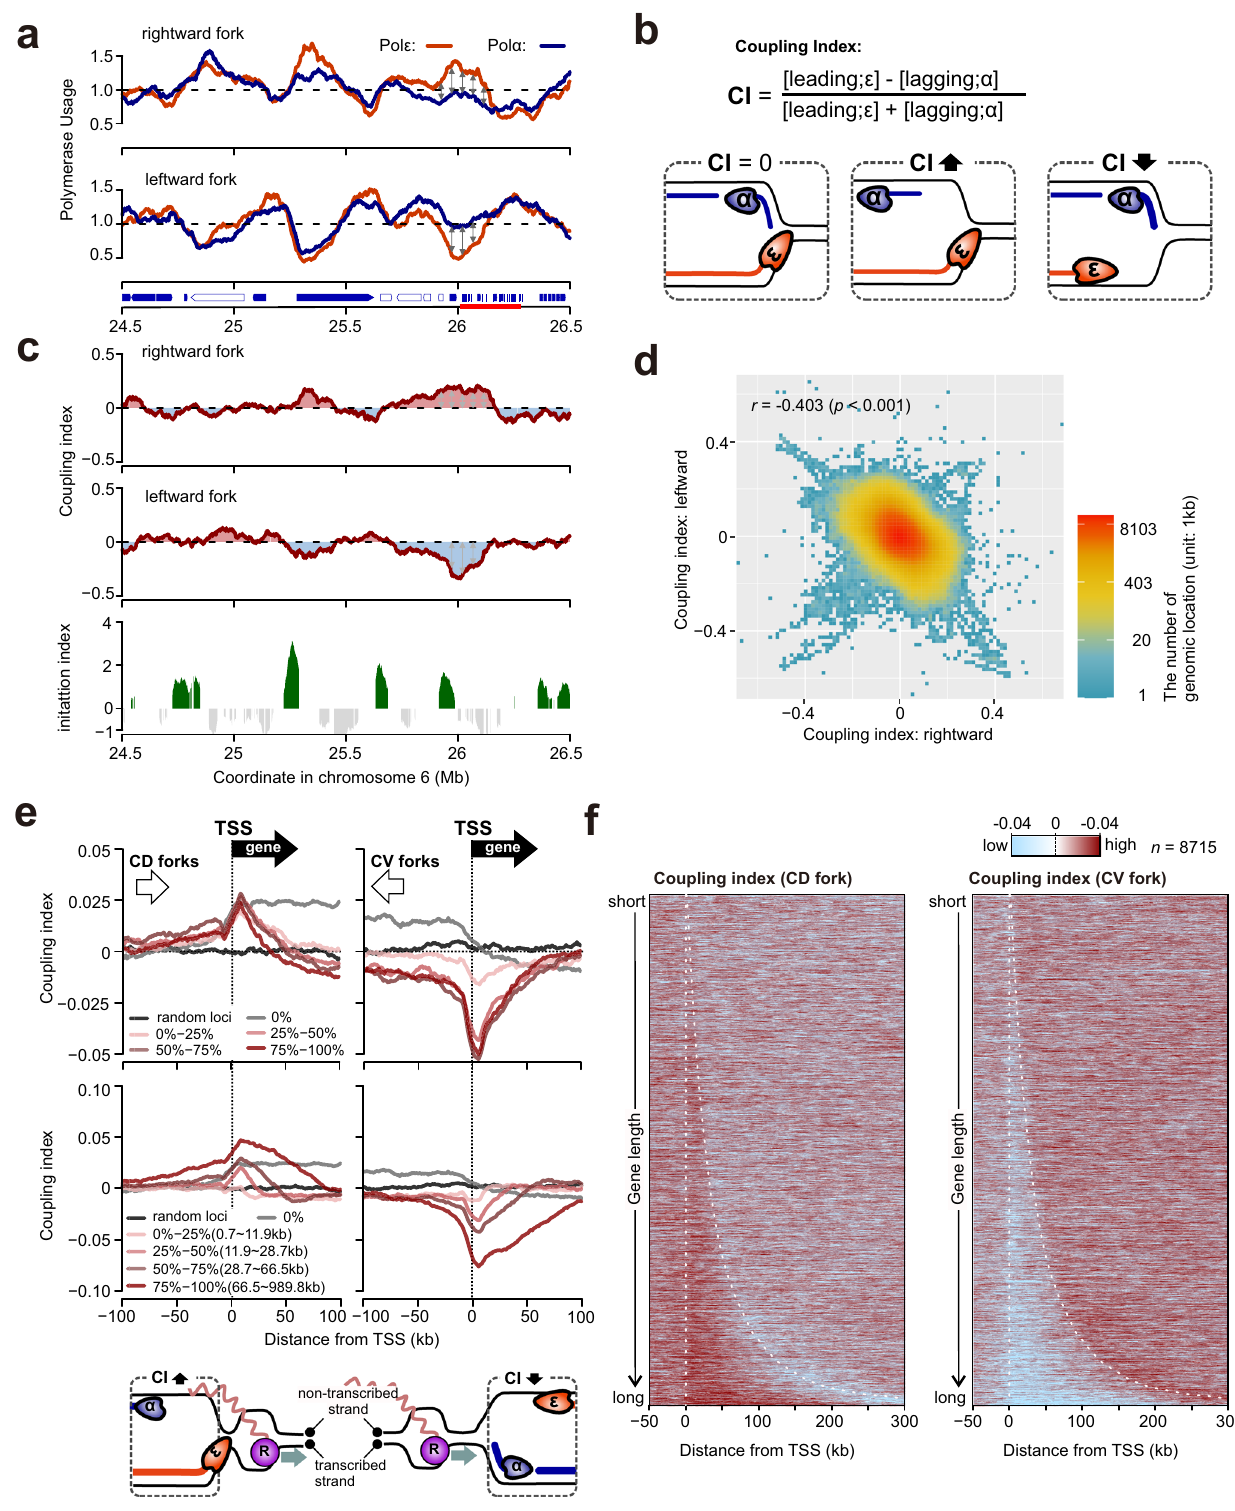
Fig. 6 | The uncoupling of leading and lagging strand DNA synthesis. a Pro fi les of polymerase usage for a region of chromosome 6. Arrows on the horizontal axis indicate active genes (blue- fi lled) and inactive genes (un fi lled). The red line on the horizontal axis indicates a cluster of histone-encoding genes. b De fi nition of cou- pling index (CI, for details see materials and methods). c Top: CI of rightward moving forks. Middle: CI of leftward moving forks. Bottom: the initiation index of the same region for comparison. d Correlation of CIs of rightward and leftward